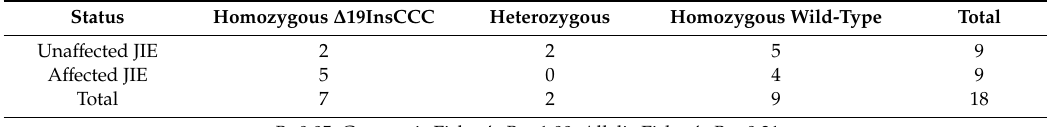
Table 1. Egyptian Arabian population (n = 18) ∆ 19InsCCC